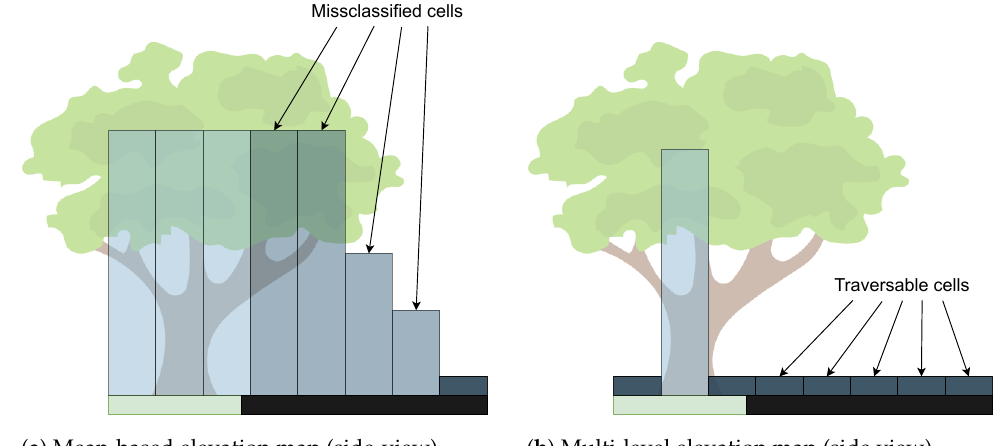
Figure 7. Elevation map techniques with